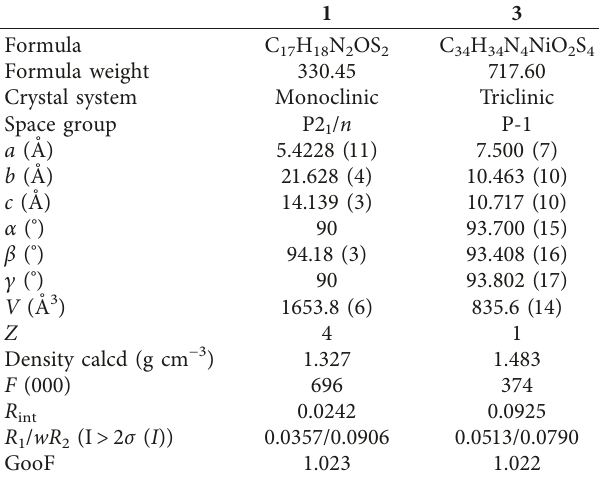
Table 1: Crystallographic data for 1 and 3